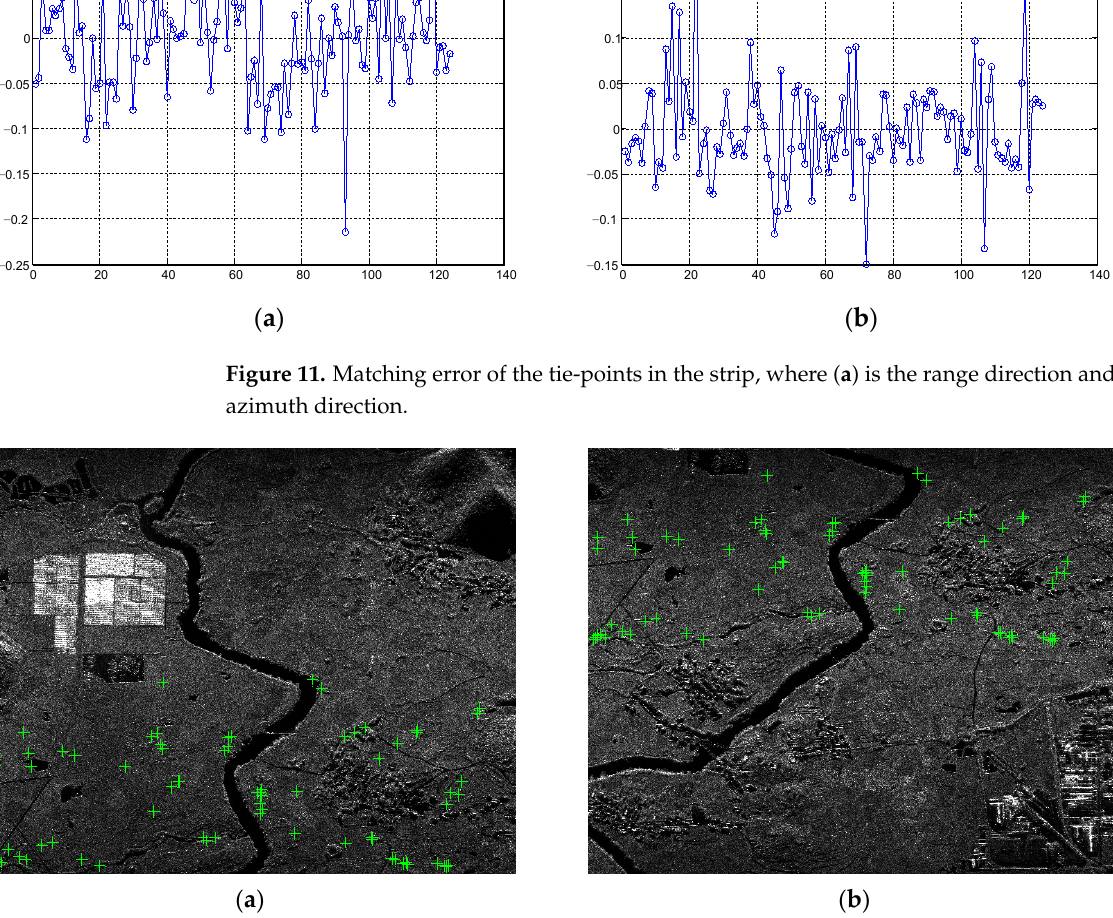
Figure 11. Matching error of the tie-points in the strip, where ( a ) is the range direction and ( b ) is the azimuth direction.